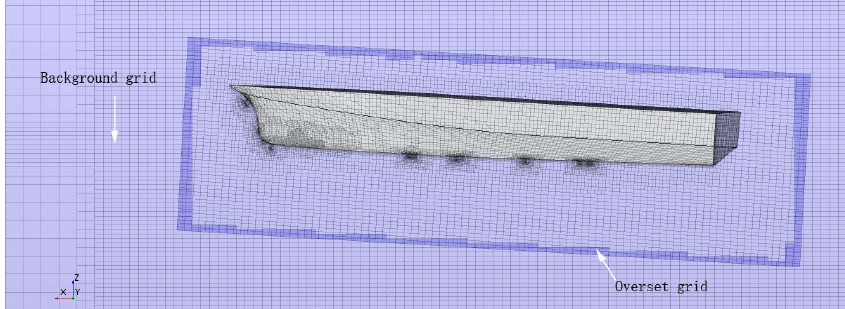
Figure 1. Background grid and overset grid.